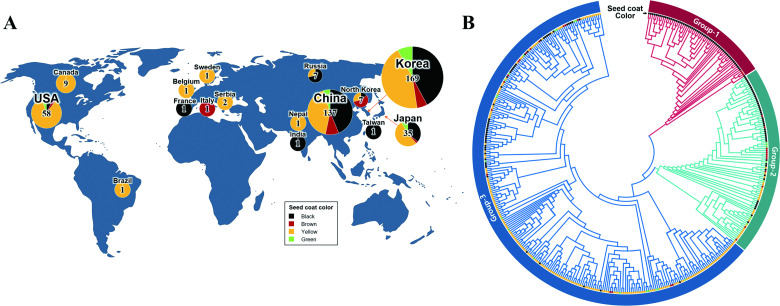
Geographic, genetic and phenotypic diversity of 438 soybean accessions.(A) Geographic and phenotypic distribution of 438 soybean cultivars. (B) Phylogenetic relationships among 438 soybean accessions. The seed color of each soybean accession is depicted in the second circle.